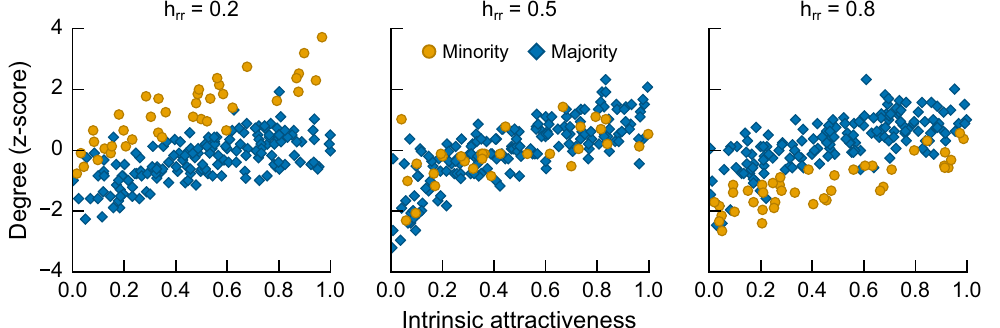
Fig. 4 Same intrinsic attractiveness but different degree centrality. The intrinsic attractiveness of individuals versus their degree in different symmetrical regimes (i.e., h 00 = h 11 = h rr ). In the neutral case ( h rr = 0.5), individuals with higher intrinsic attractiveness have a higher degree regardless of their group membership. In nonneutral regimes, however, degree centrality disguises intrinsic attractiveness. In a heterophilic regime ( h rr = 0.2), minority members have a higher degree compared to their majority counterparts with the same intrinsic attractiveness. In a homophilic regime ( h rr = 0.8), highly attractive minority members do not have similar degree centrality to that of their majority